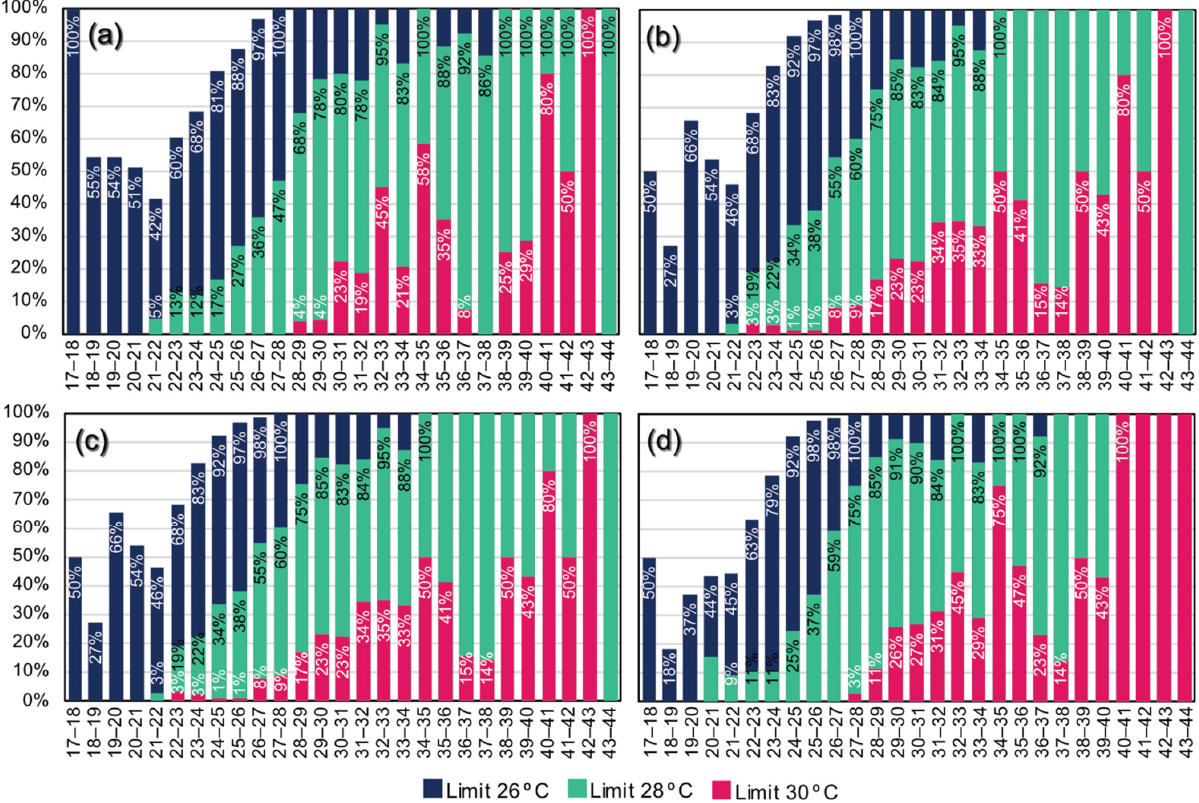
Figure 13. Internal temperature limit exceedance according to external temperature; y-axis: the probability of exceeding a certain limit based on the measurements; x-axis: external temperature. ( a ) Kitchen, ( b ) small bedroom, ( c ) living room, ( d ) large bedroom. The previously presented ODH 26 indicator is an efficient way to characterise and compare the summer overheating of dwellings and rooms (see Table 2). The indicator value in the two bedrooms is the highest at over 1700 Kh, while the lowest in the living room is around 1000 Kh. It can therefore be seen that the overheating in different parts of